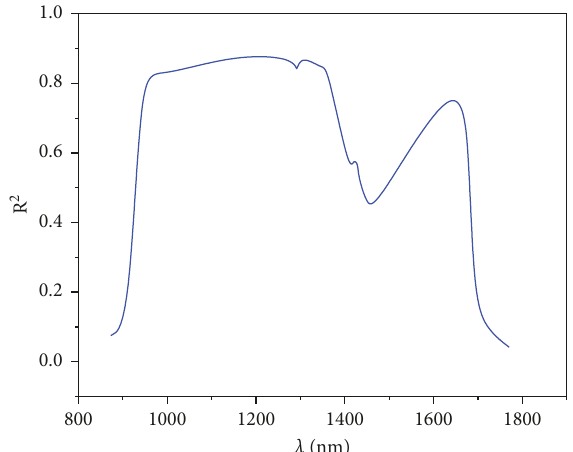
Figure 4: Univariate regression R 2 of gray level of each band on leaf nitrogen